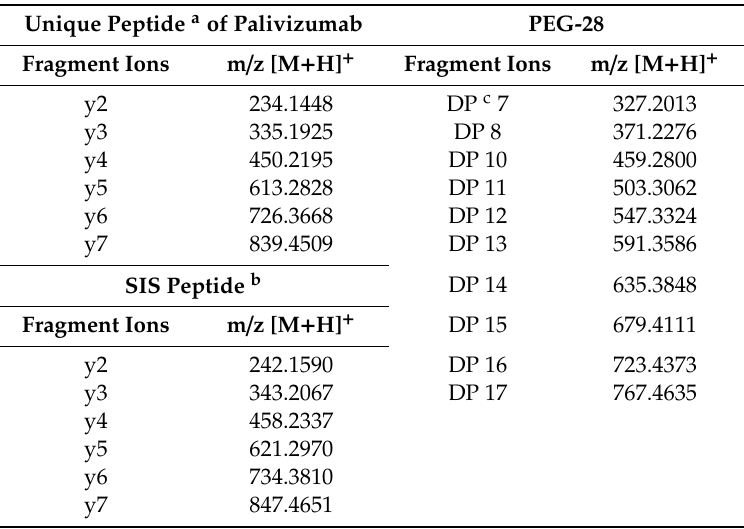
Table 2. Transitions used for PRM-based